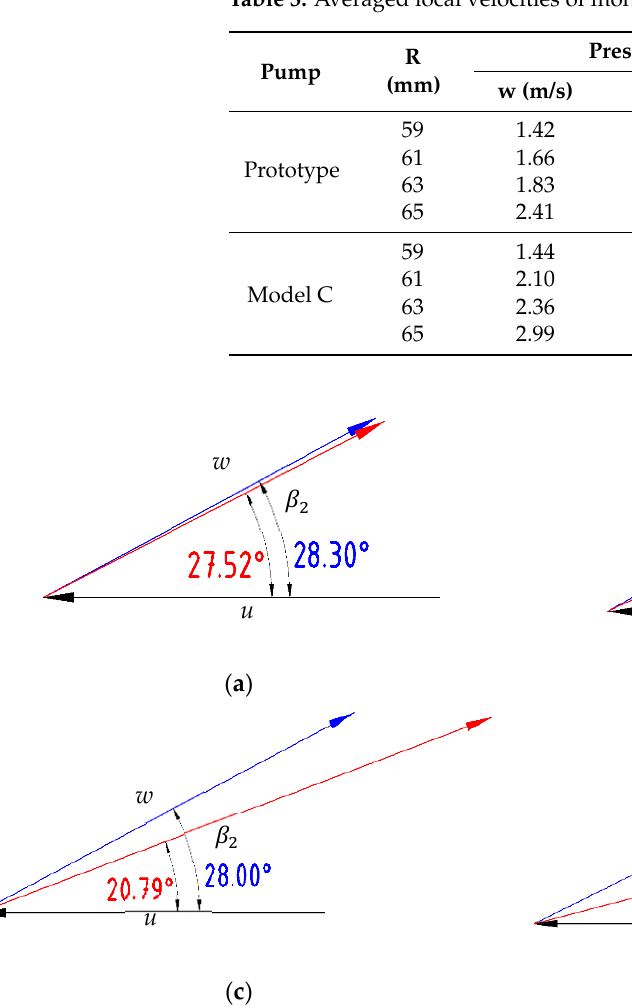
Table 3. Averaged local velocities of monitor points.